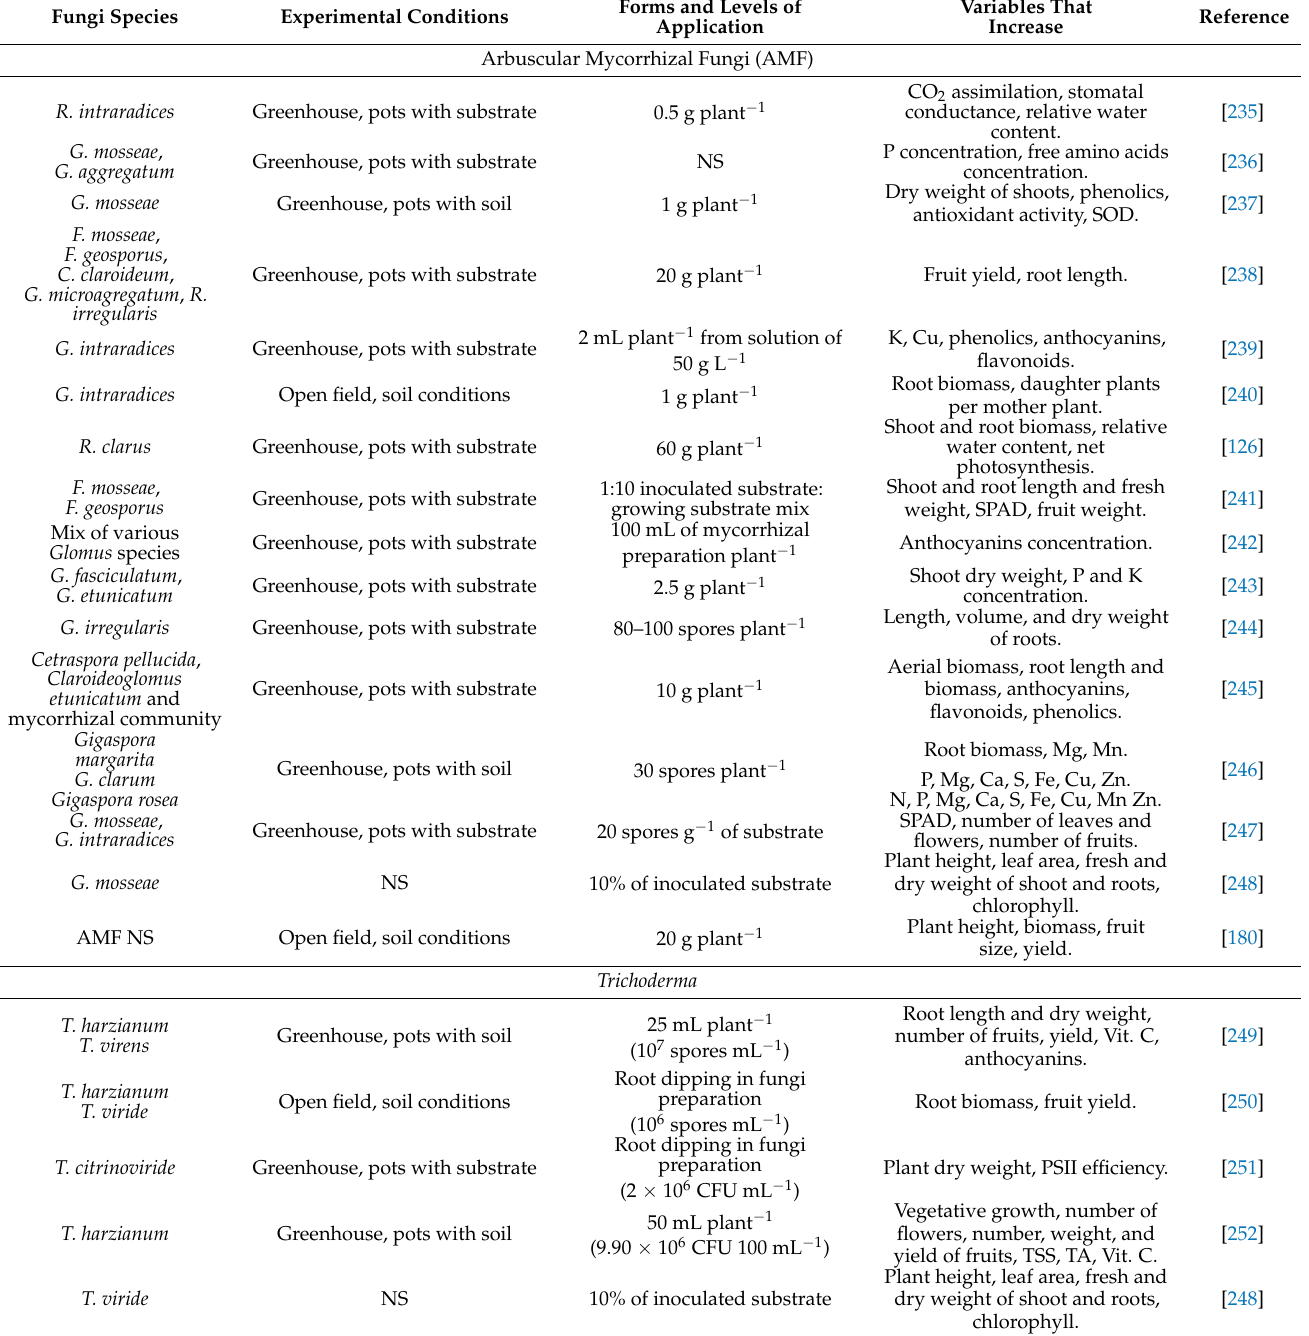
Table 10. Positive effects of arbuscular mycorrhizal fungi and Trichoderma applications on some growth or quality variables of strawberry